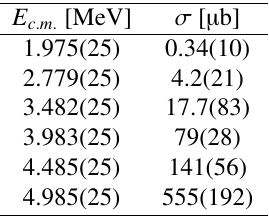
Table 1. Total cross-section values σ tot for the 87 Rb(p, γ ) 88 Sr reaction depending on the center-of-mass energy corrected for the energy loss in target.